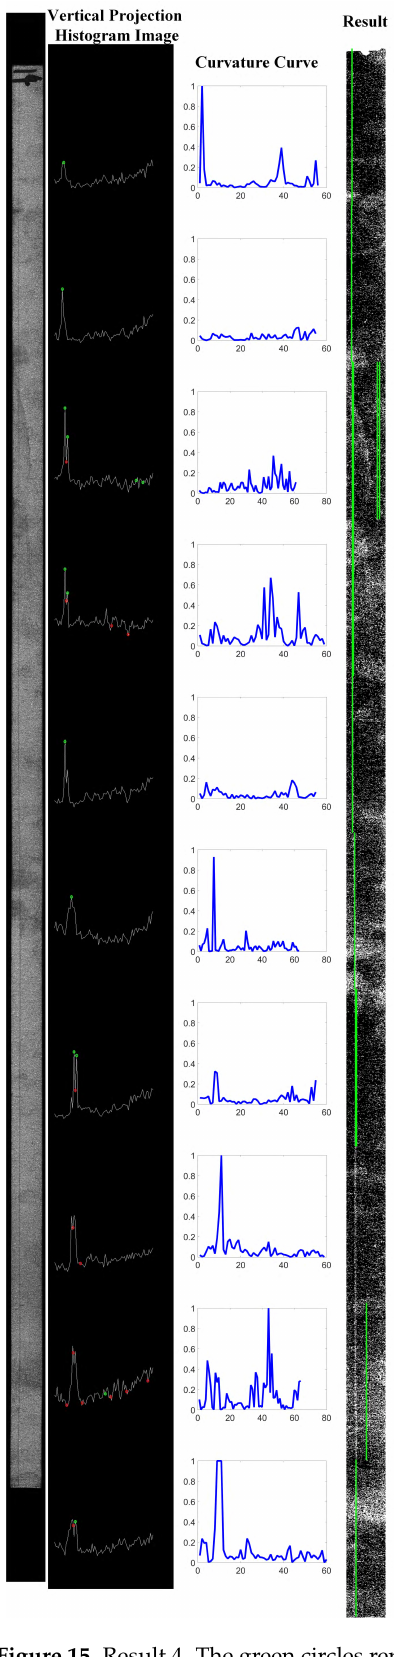
Figure 15 Figure 15. Result 4. The green circles represent local maximums, red circles represent local valleys, and the green lines represent the detected